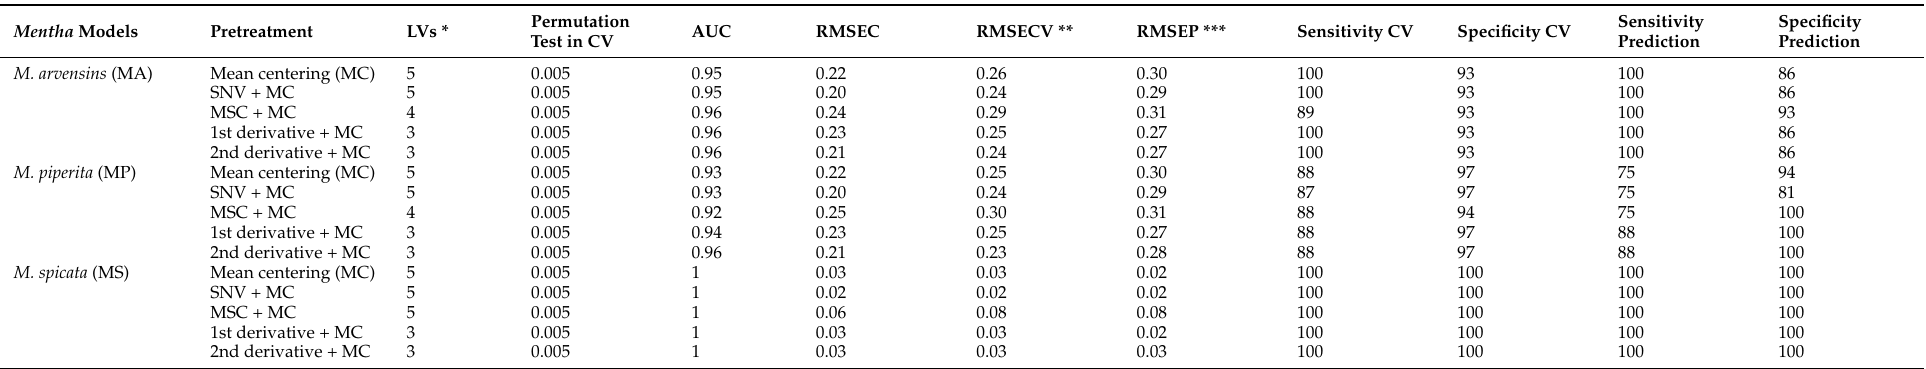
Table 1. Results of PLS-DA models applied on Mentha , dataset for both cross-validation of the calibration set and prediction of test set using different pretreatment methods.